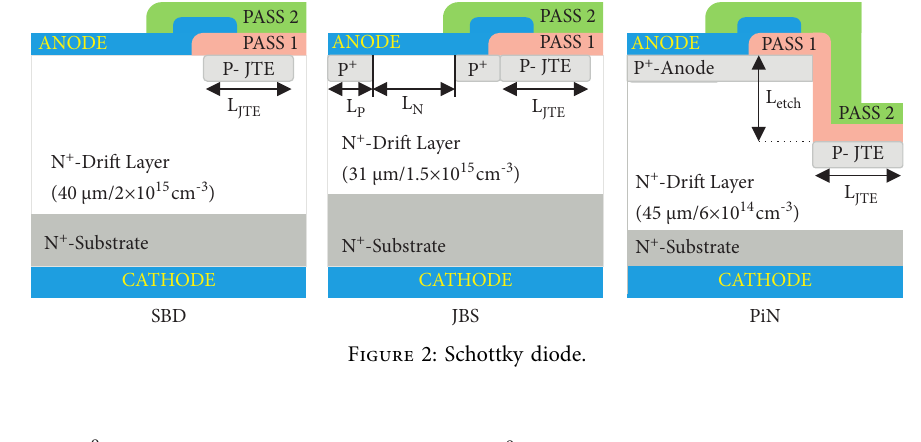
Figure 2: Schottky diode.